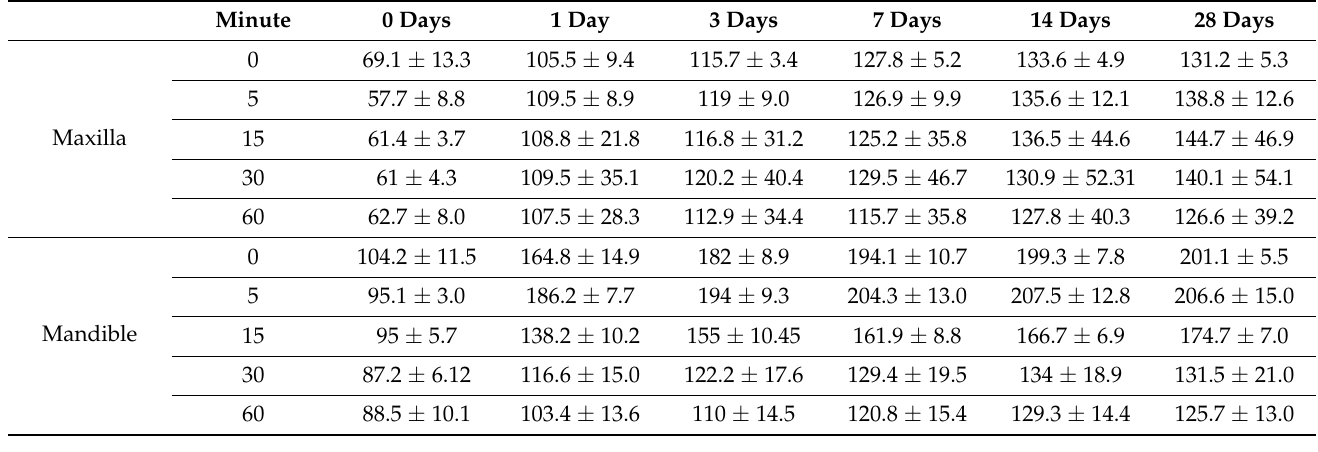
Table 3. RMSE mean, standard deviation of trueness according to postcuring time and date after printing of the maxillary and mandibular denture bases. Unit of measure: µ m.